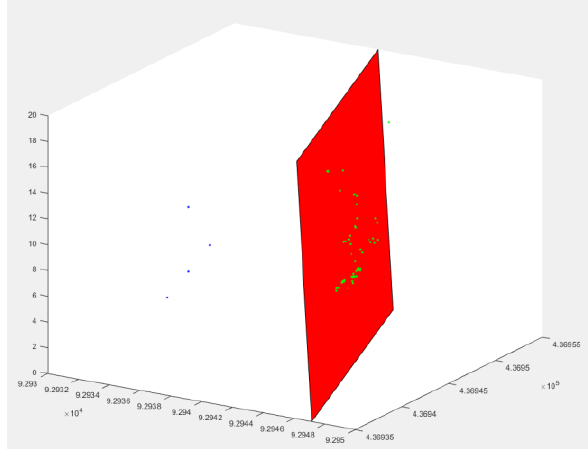
Figure 5. Plane fitting example. Green: object points. Red: fit plane. Blue: Three recording locations (image triplet) plus